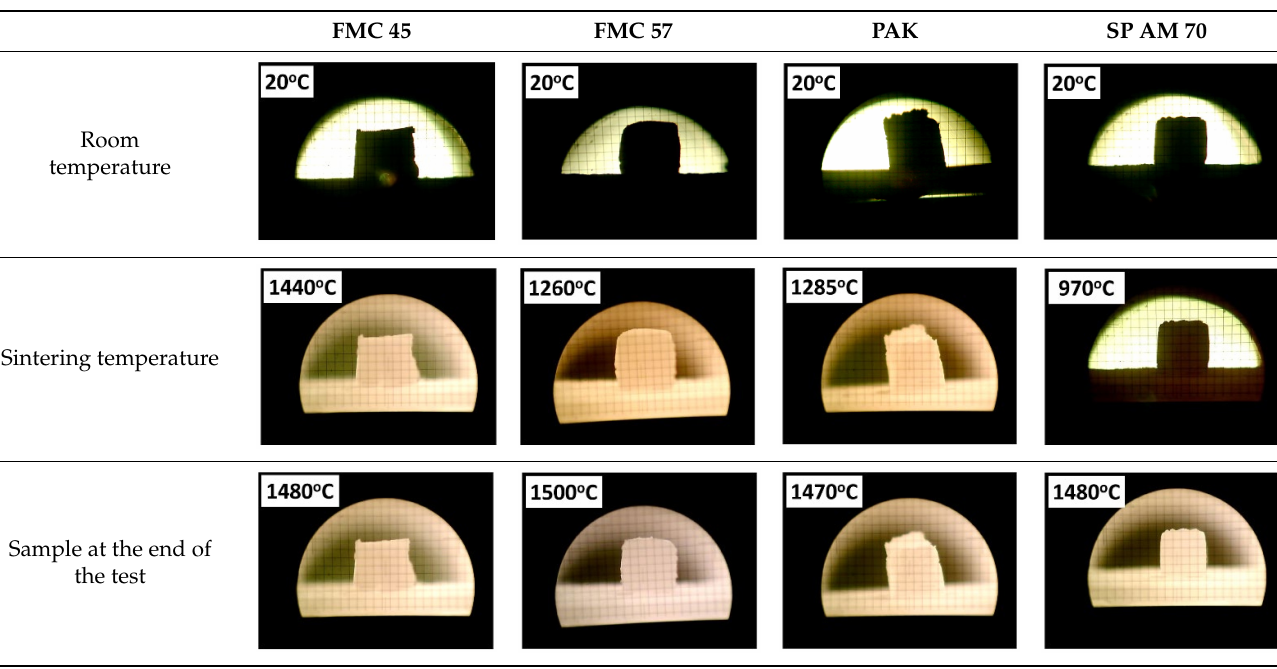
Figure 4. Results of hot-stage microscopy test for refractory raw material–Cu slag mixture. The sintering temperature was set as 2% linear shrinkage of the test sample. Table 4. Microscopic view of the test raw material–Cu slag mixtures during the hot-stage mi- croscopy